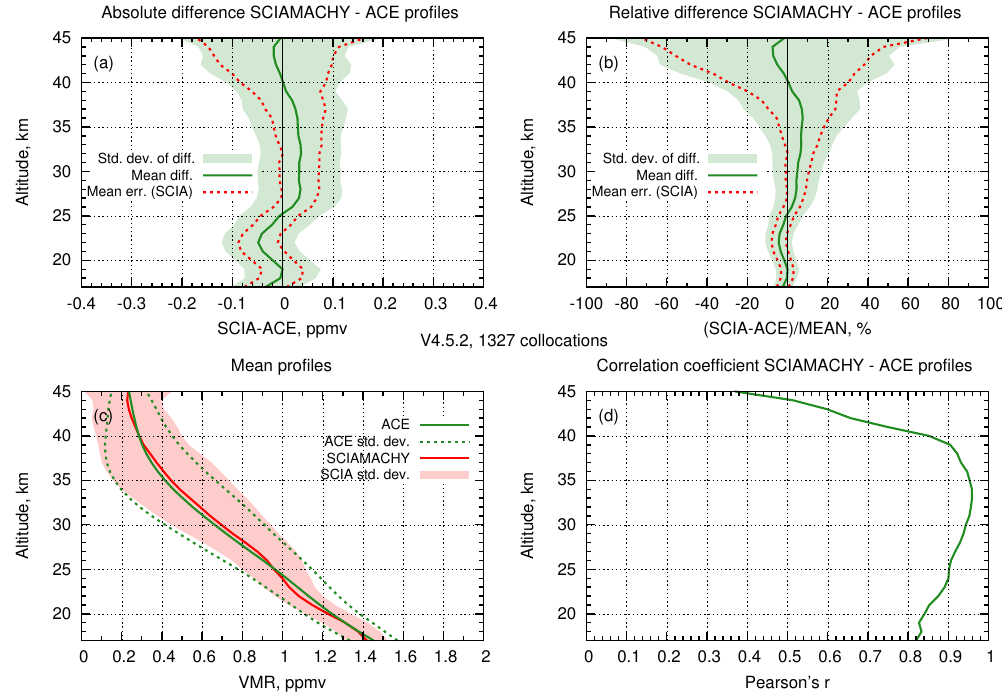
Figure 8. Comparison of retrieved SCIAMACHY CH 4 profiles (ONPD V4.5.2) with ACE-FTS data (V3.5). (a) Mean absolute difference (green) plus/minus one standard deviation (shaded area) and mean absolute error of SCIAMACHY data (dotted red line). (b) Mean relative difference (green) plus/minus one standard deviation (shaded area) and mean relative error of SCIAMACHY data (dotted red line). (c) Mean profiles and standard deviations (red: SCIAMACHY, green: ACE-FTS). (d) Correlation between SCIAMACHY and ACE-FTS